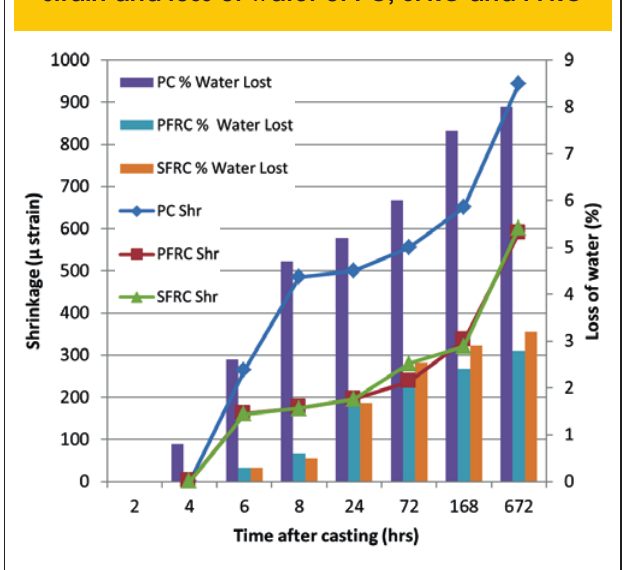
Figure 4 – Results of tests on shrinkage strain and loss of water of PC, SFRC and